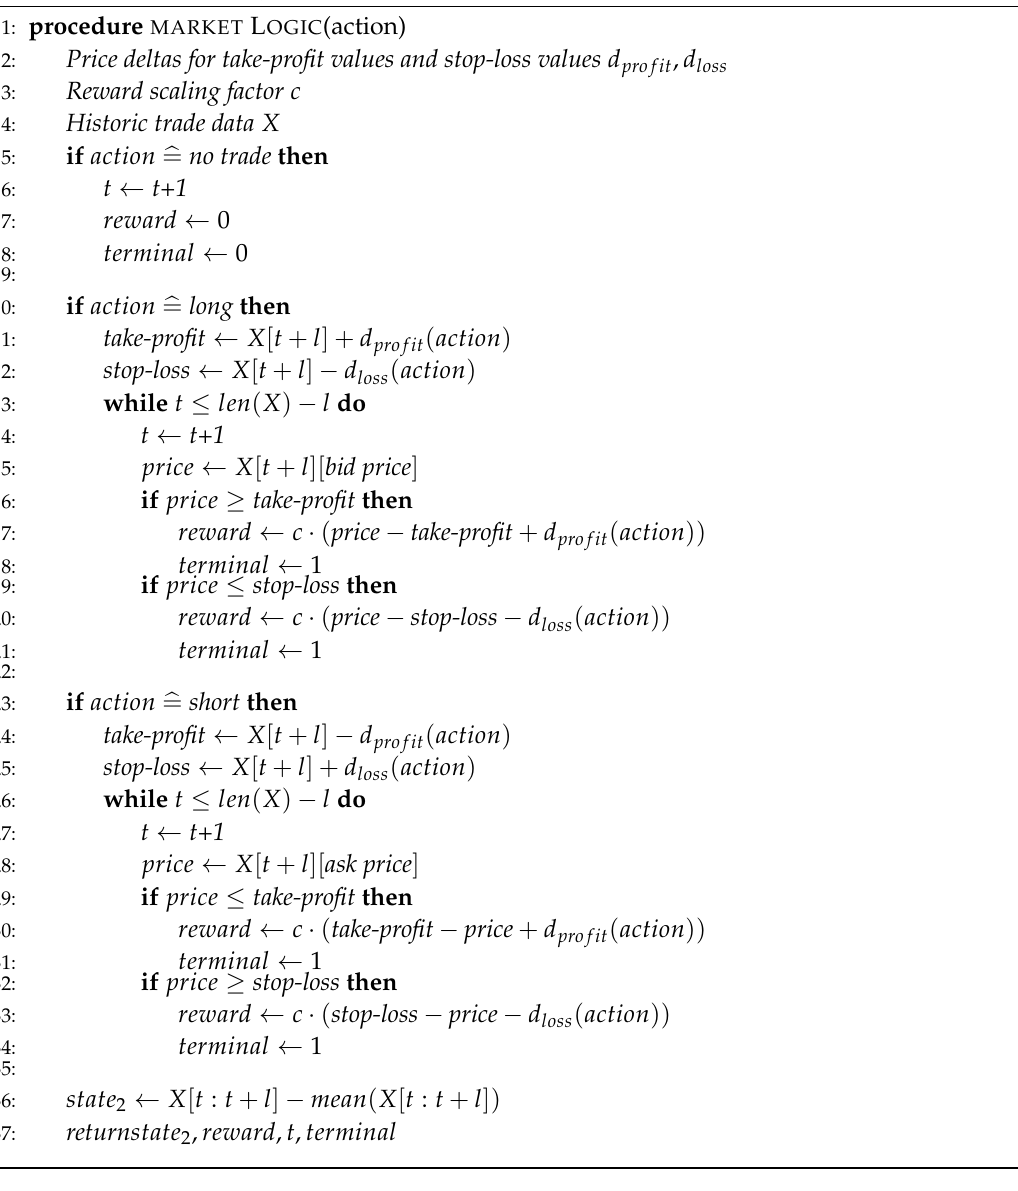
Algorithm A2 Market logic Price deltas for take-profit values and stop-loss values d profit , d loss Reward scaling factor c Historic trade data X